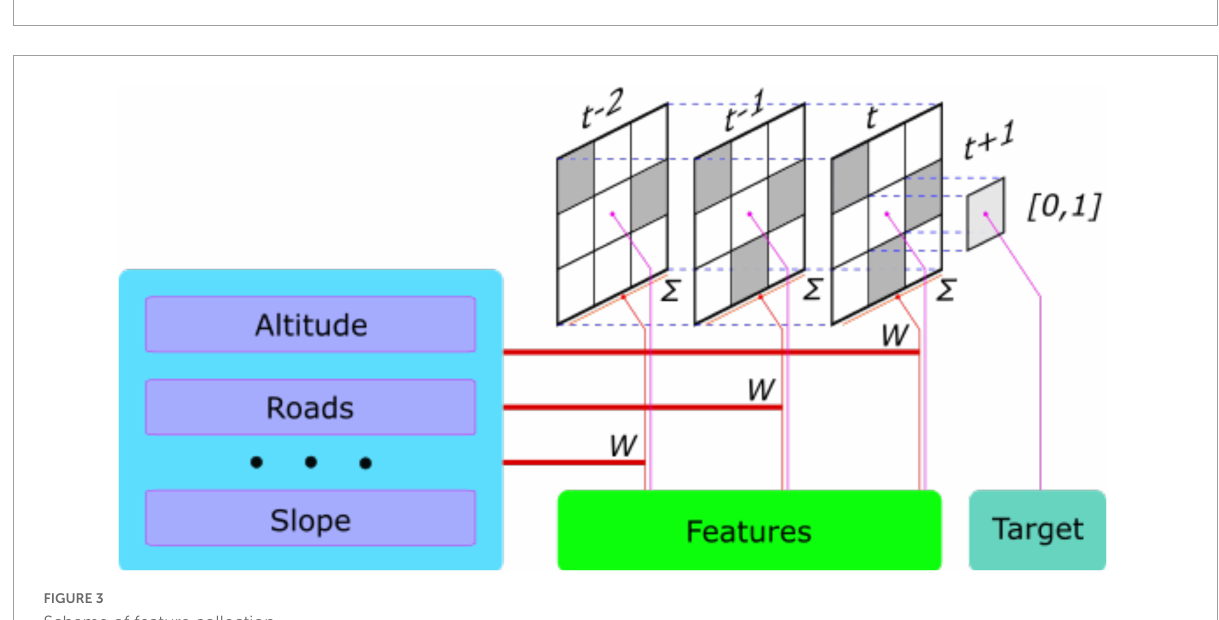
FIGURE2 Decayed deforestation in relation to the year 2000, with a decay factor of δ = 0.85.